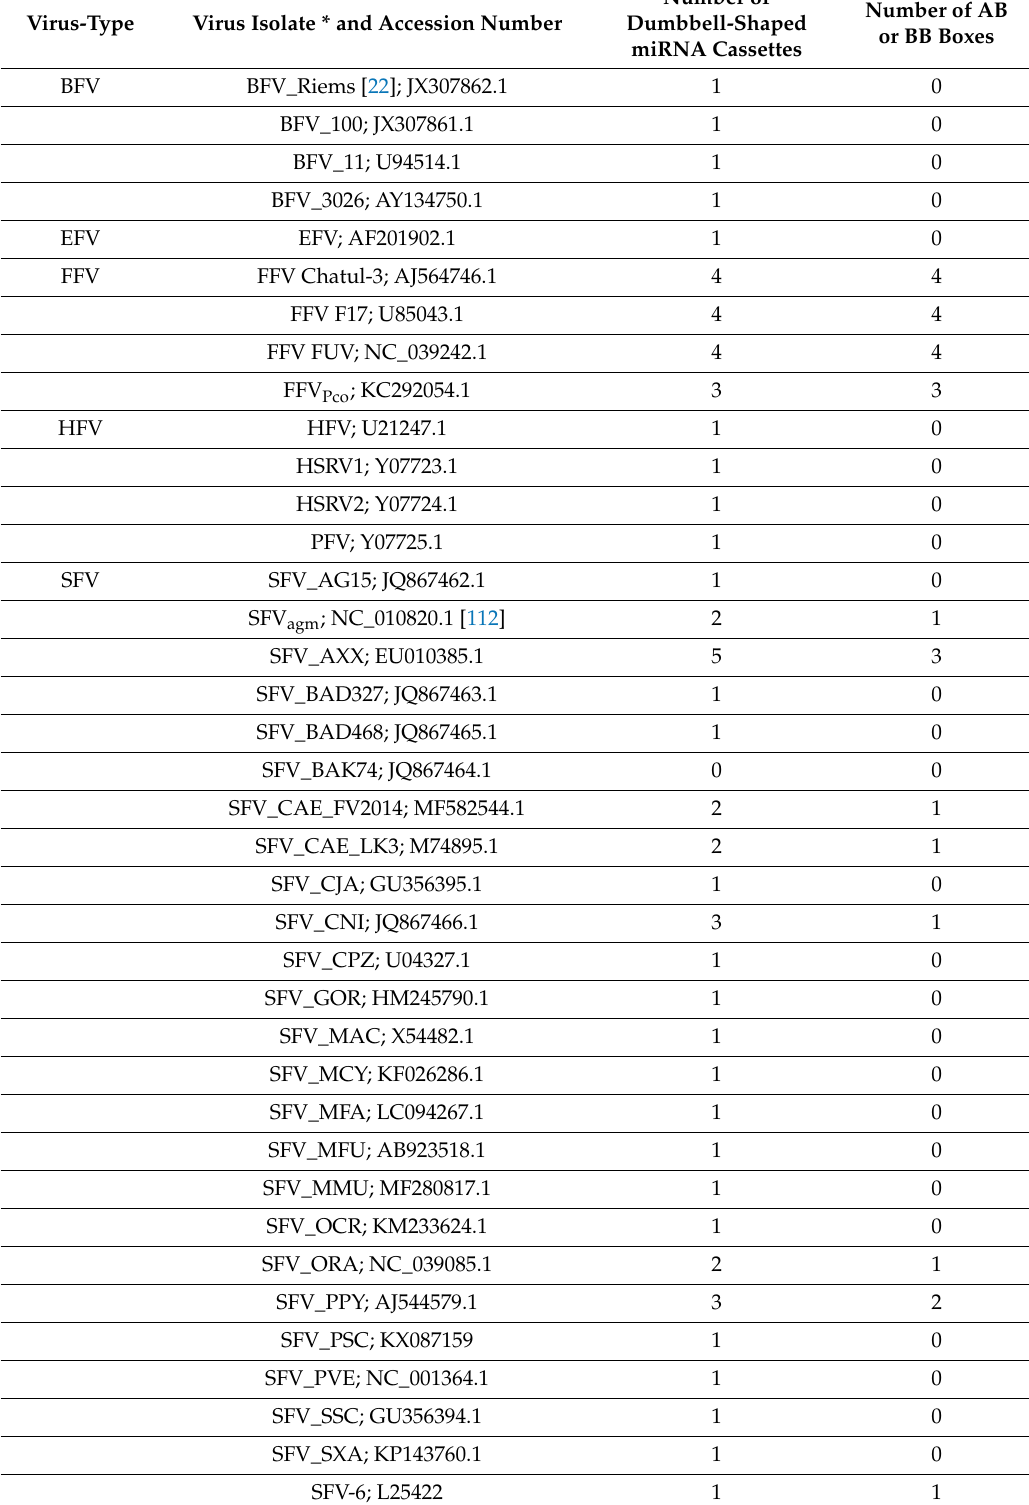
Table 2. Results of bioinformatics on dumbbell-type RNA Pol III cassettes in the LTRs of selected FVs flanked by consensus TATA boxes and termination